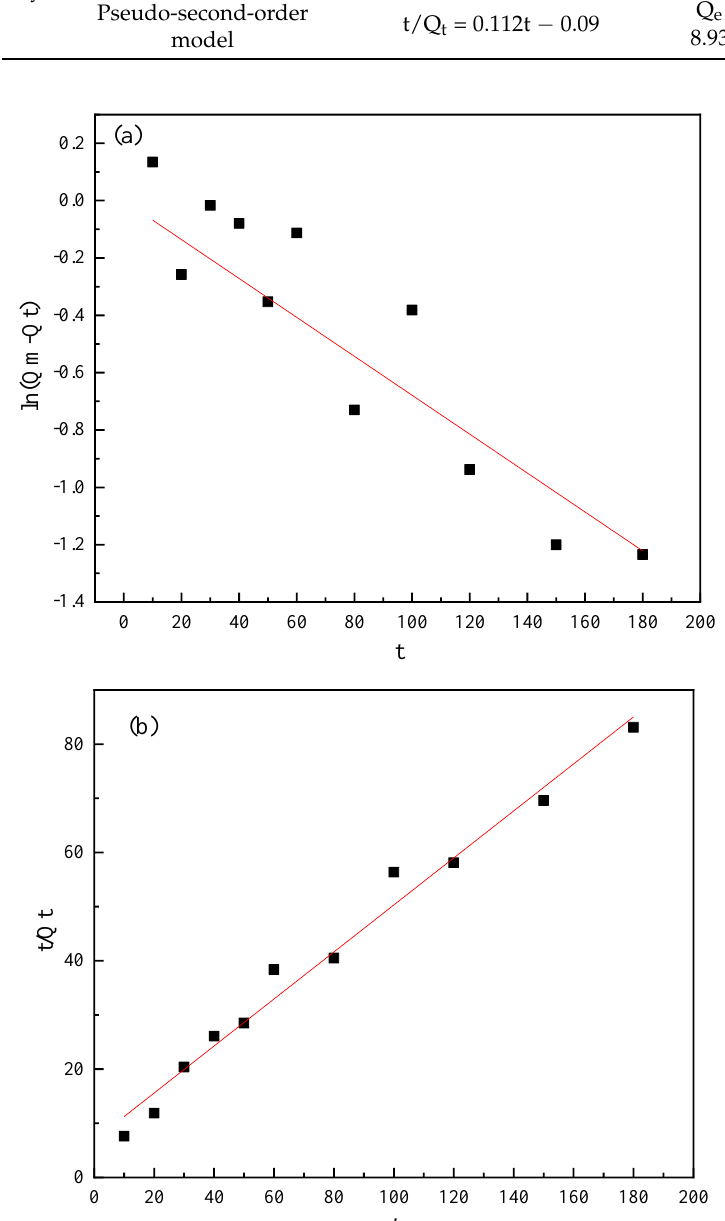
Figure 6. Kinetic fitting of thiourea adsorption on mica: ( a ) pseudo-first-order kinetic plot and ( b ) pseudo-second-order kinetic plot.